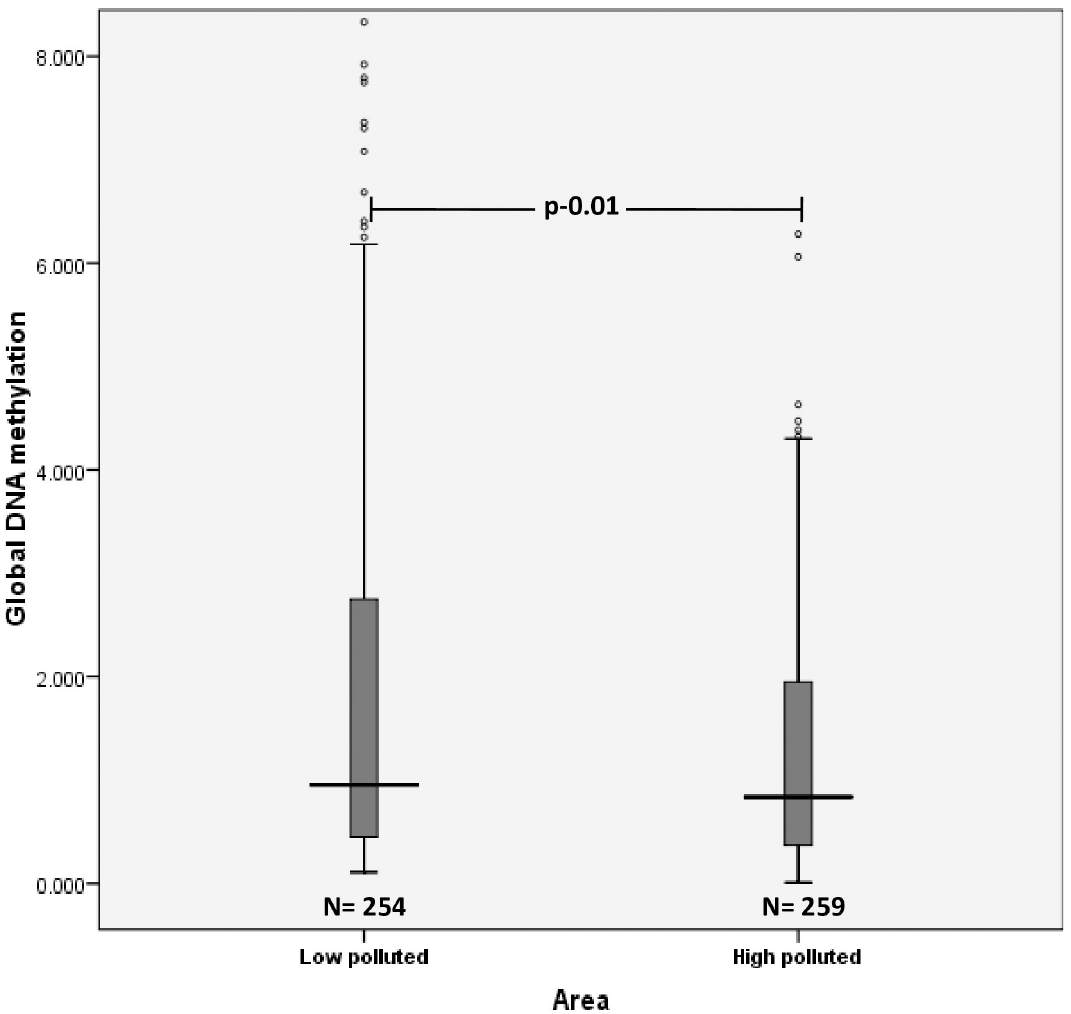
Fig 1. Distribution of median levels of global DNA methylation in low and high polluted